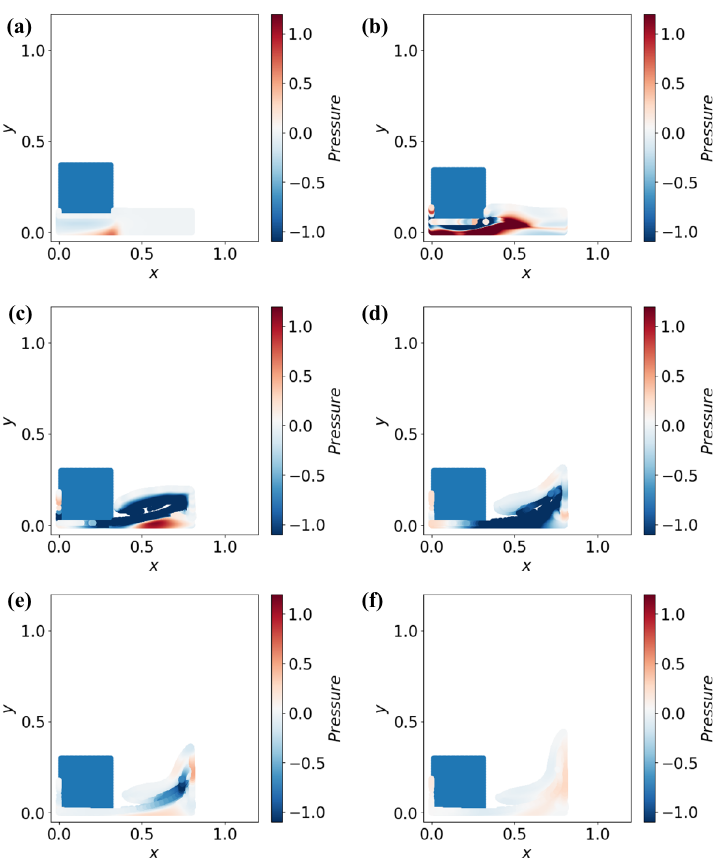
Fig. 7 The surge morphology and pressure distribution diagram. Water depth D = 0 . 116 m and particle density n = 200 / m. Each map corresponds to a different moment. a 2 dt. b 4 dt. c 7 dt. d 9 dt. e 10 dt. f 12